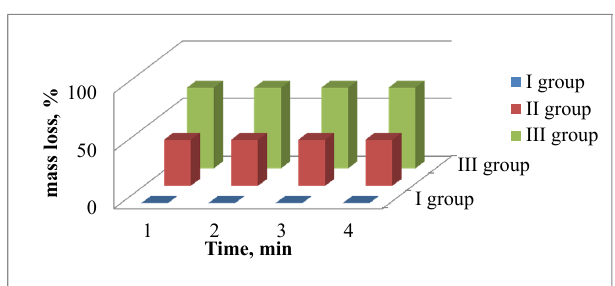
Fig. 1. The nature of the interaction of basalt fiber, various groups, in etching